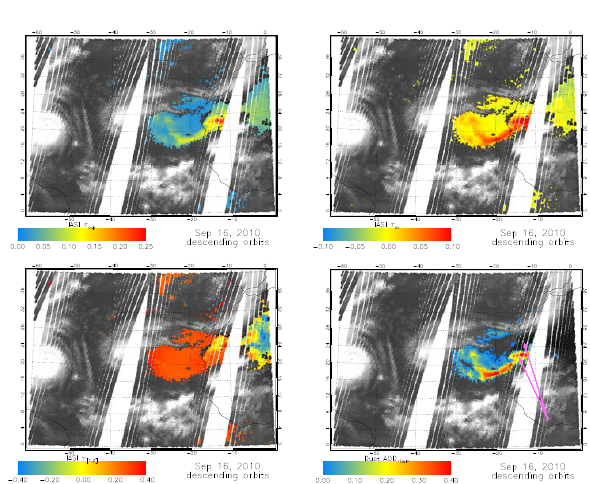
Fig. 3. Examples of internal retrieval variables and 10µ m AOD for September 16 (descending orbits). These are τ eqv (top left), τ sv (top right), τ [1 , 2] (bottom left) and AOD 10 μm (bottom left). The arrows indicate the position of the observations of the example τ -spectrain Fig.2.